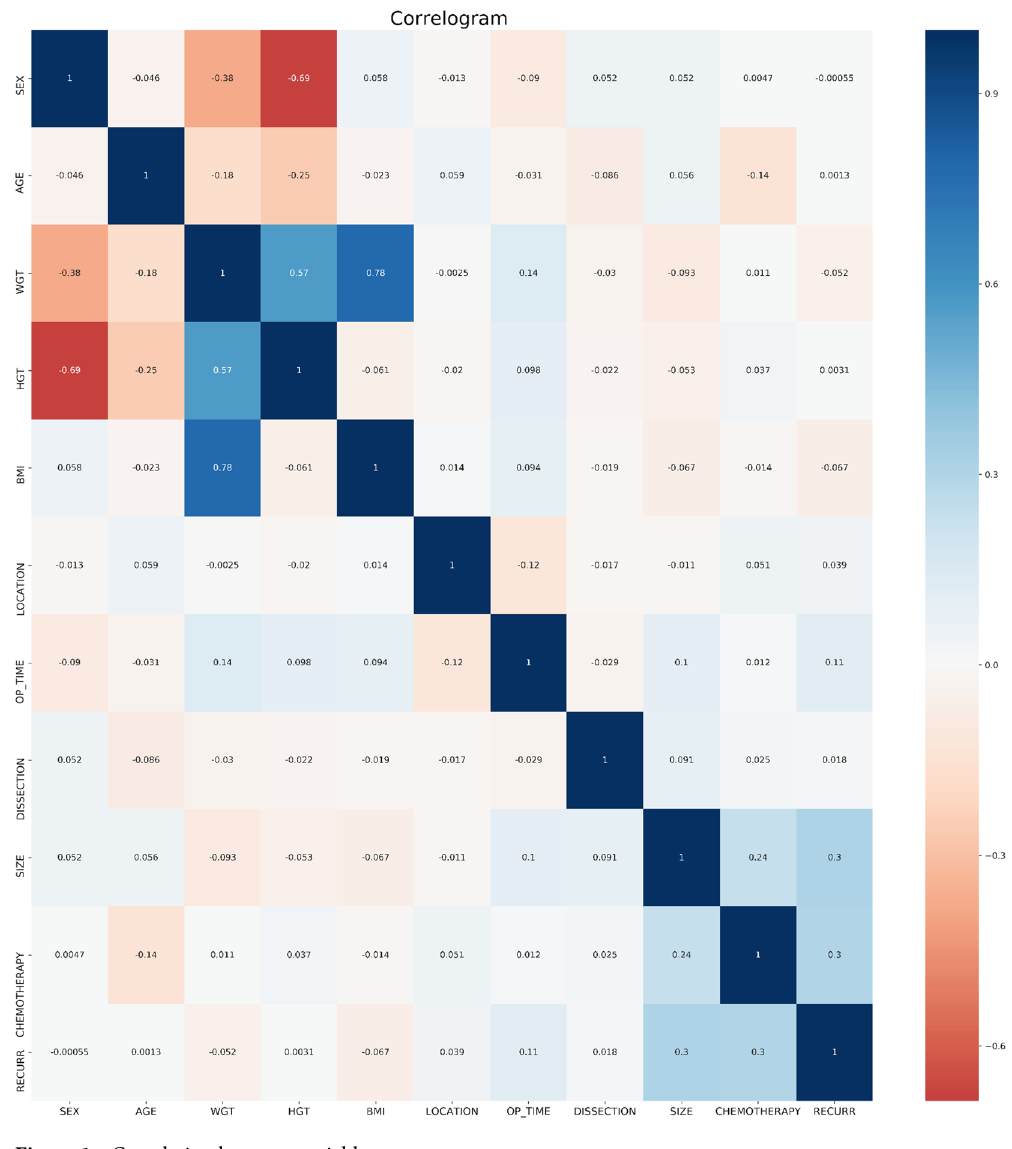
Figure 1. Correlation between